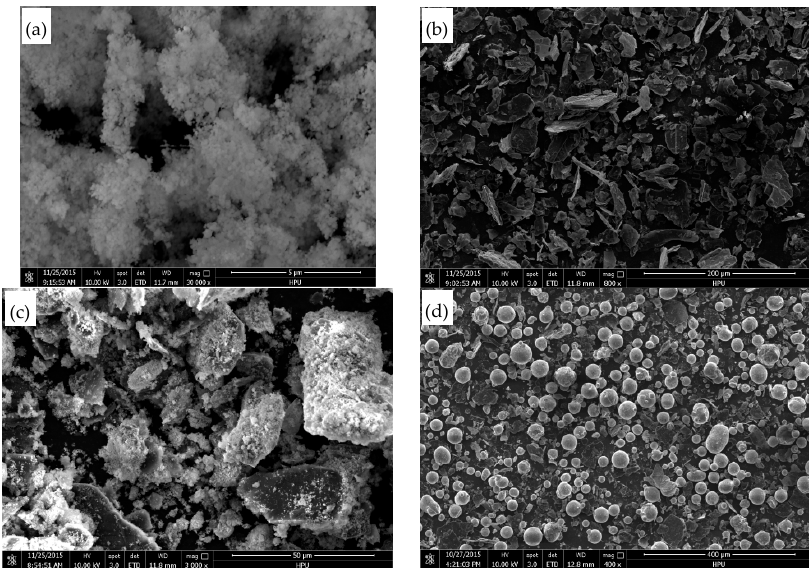
Figure 1. Scanning electron microscopy (SEM) micrographs of ( a ) nano-Al powders, ( b ) graphite flakes, ( c ) graphite flakes coated with nano-aluminum (NAGF) powders and ( d ) the mixed composite powders with graphite content of 10 vol.%.